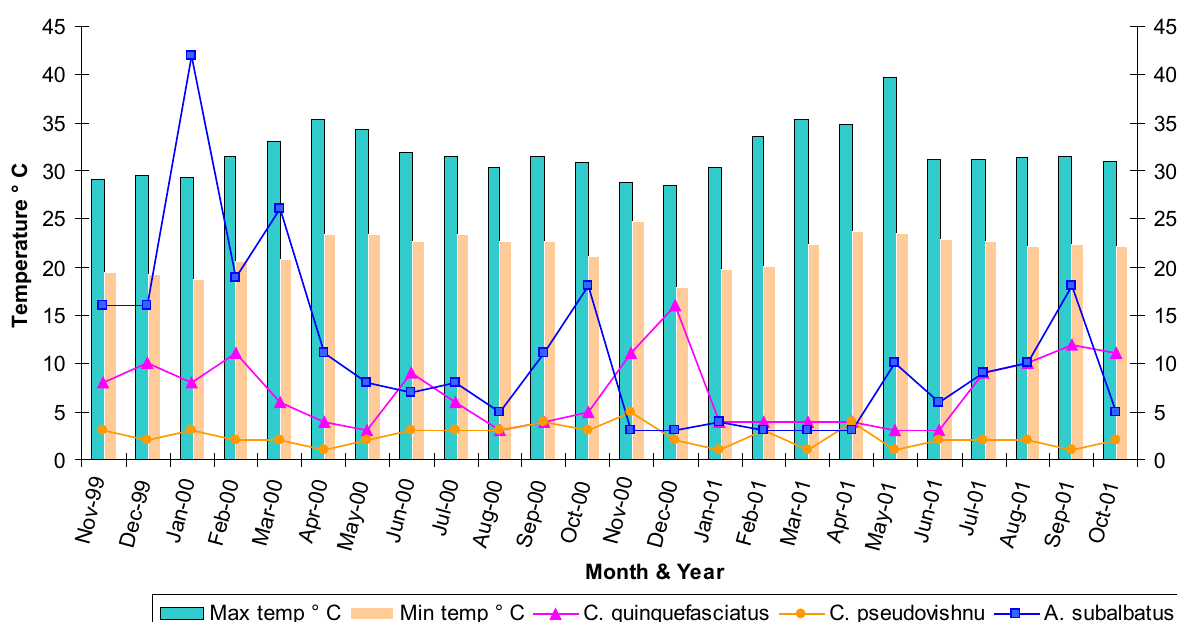
Figure 3. Population dynamics of mosquito species in relation to rainfall in North Coimbatore POPULATION DYANMICS OF MOSQUITO SPECIES IN RELATION TO RAINFALL IN NORTH COIMBATORE